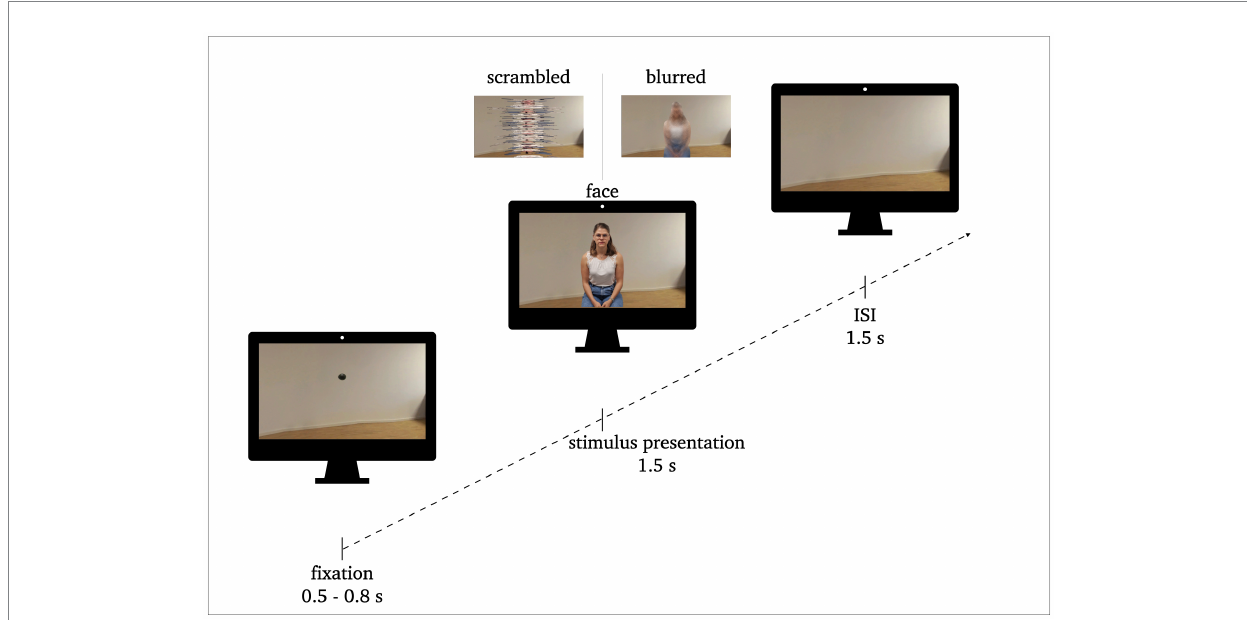
FIGURE 1 Procedure of stimulus presentation: 0.5–0.8 s fixation, 1.5 s stimulus presentation, 1.5 s inter stimulus interval (ISI). Exemplary stimuli of face conditions and perceptual control conditions (scrambled, blurred) are